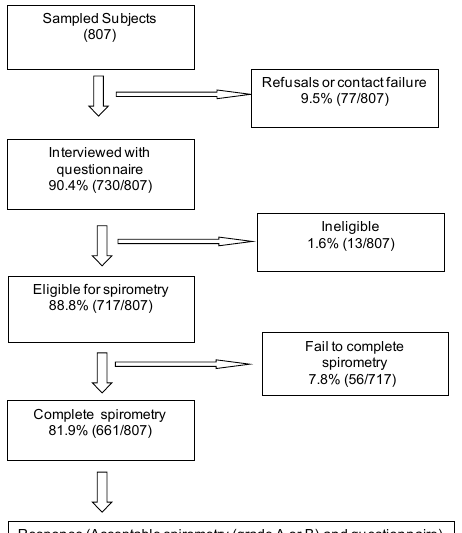
Figure 1. Response rate of questionnaire and